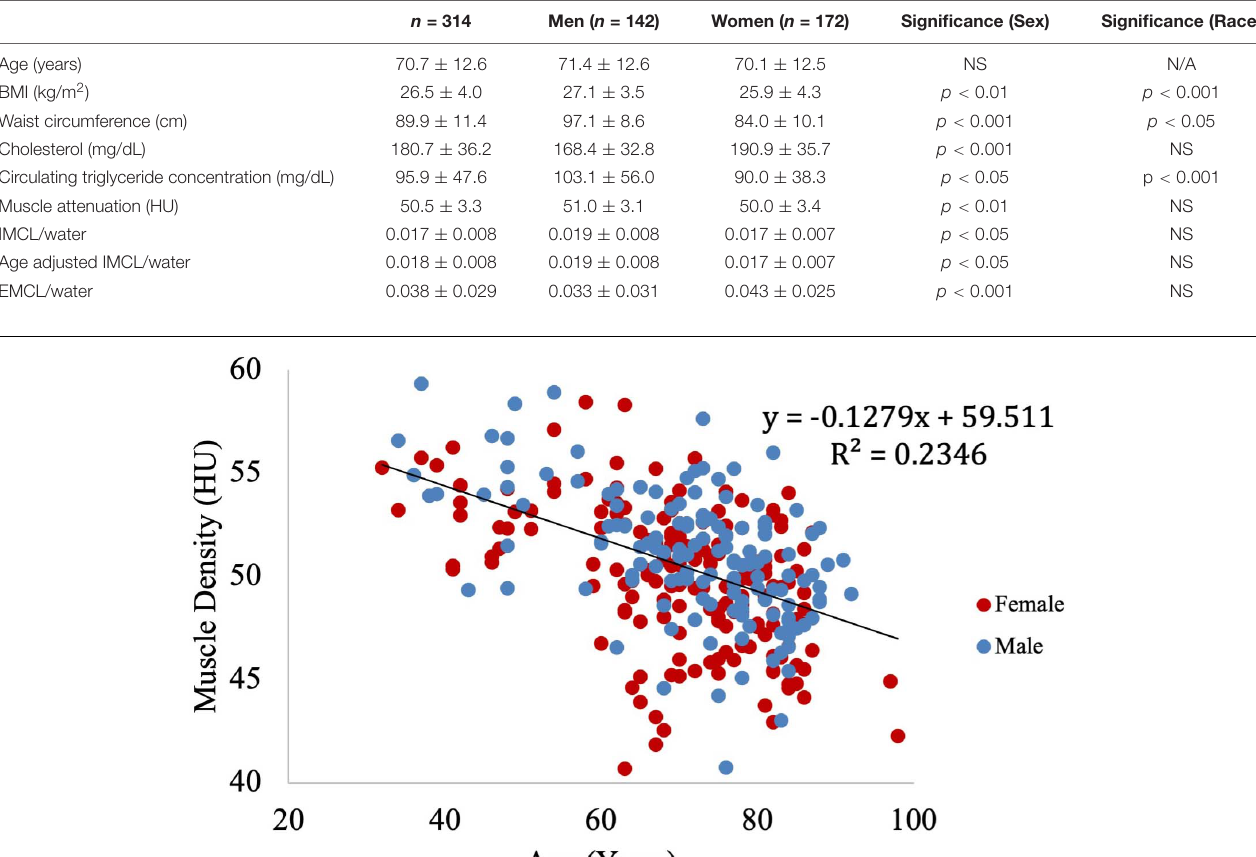
TABLE 1 | Participant characteristics.